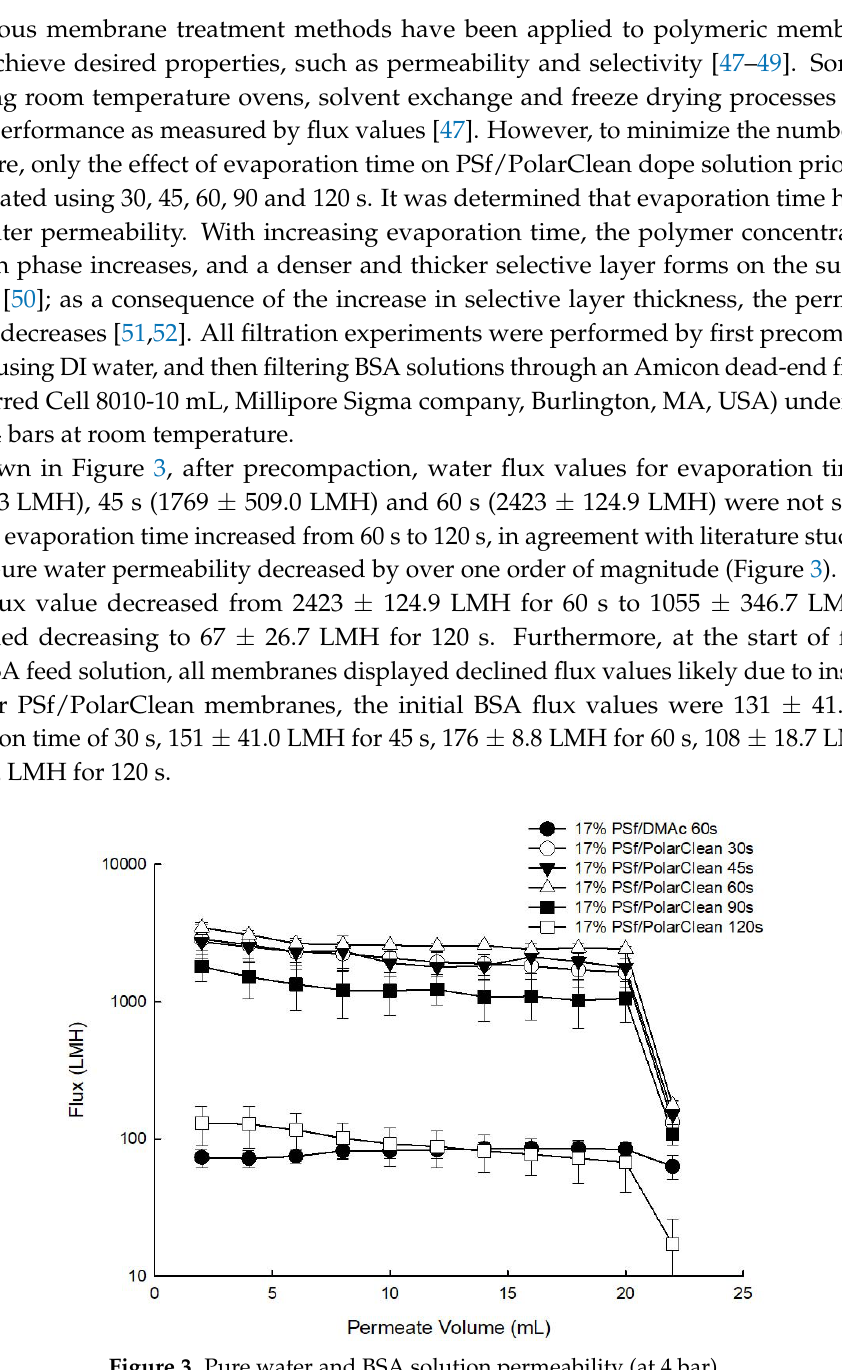
Figure 3. Pure water and BSA solution permeability (at 4 bar).